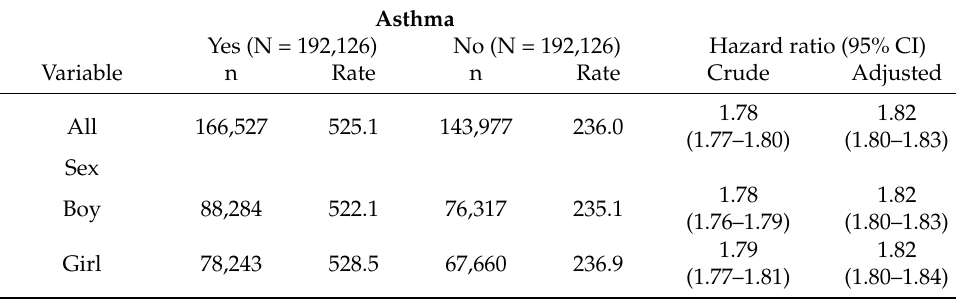
Table 2. Incidence number and rate of acute bronchitis, asthma cohort to non-asthma cohort hazard ratio and allergic rhinitis cohort to non-allergic rhinitis cohort hazard